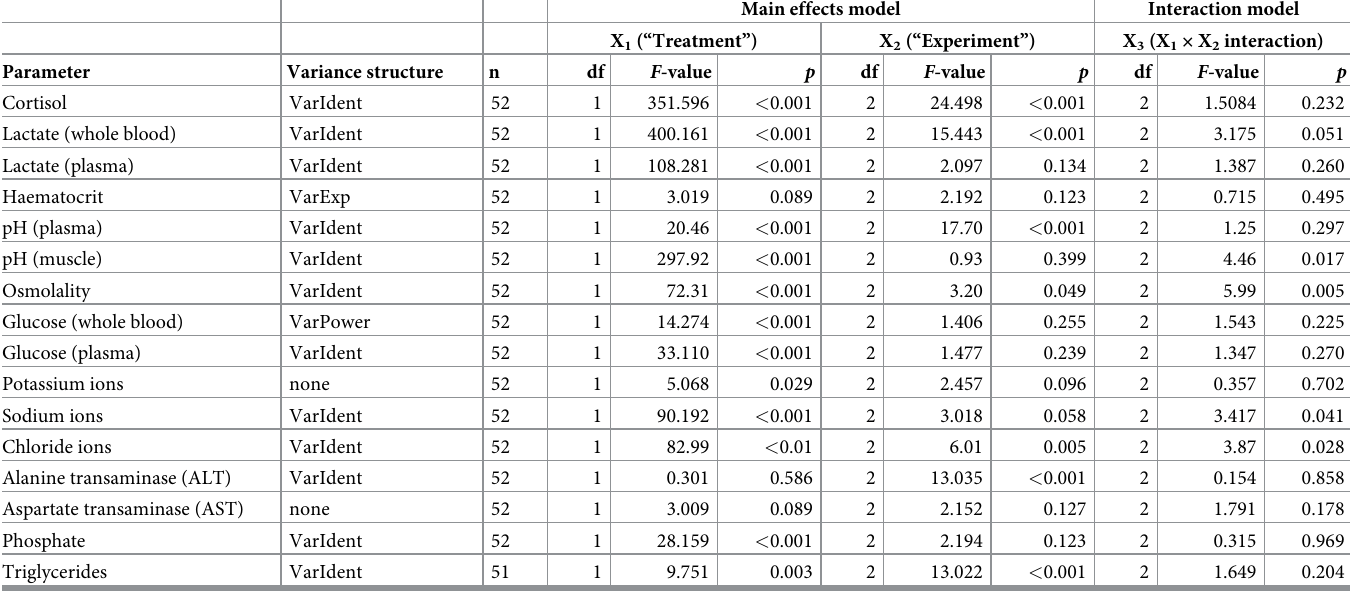
Table 3. Blood and muscle physiology statistical results. Statistical test results and associated significance of the interaction and main effects of “treatment” (either con- trol or crowded) and “experiment” (either E19, E20 or net pen) on various Atlantic mackerel blood and muscle physiological parameters. Models were fitted using General- ized Least Squares (GLS) regression with a variety of variance structures, as